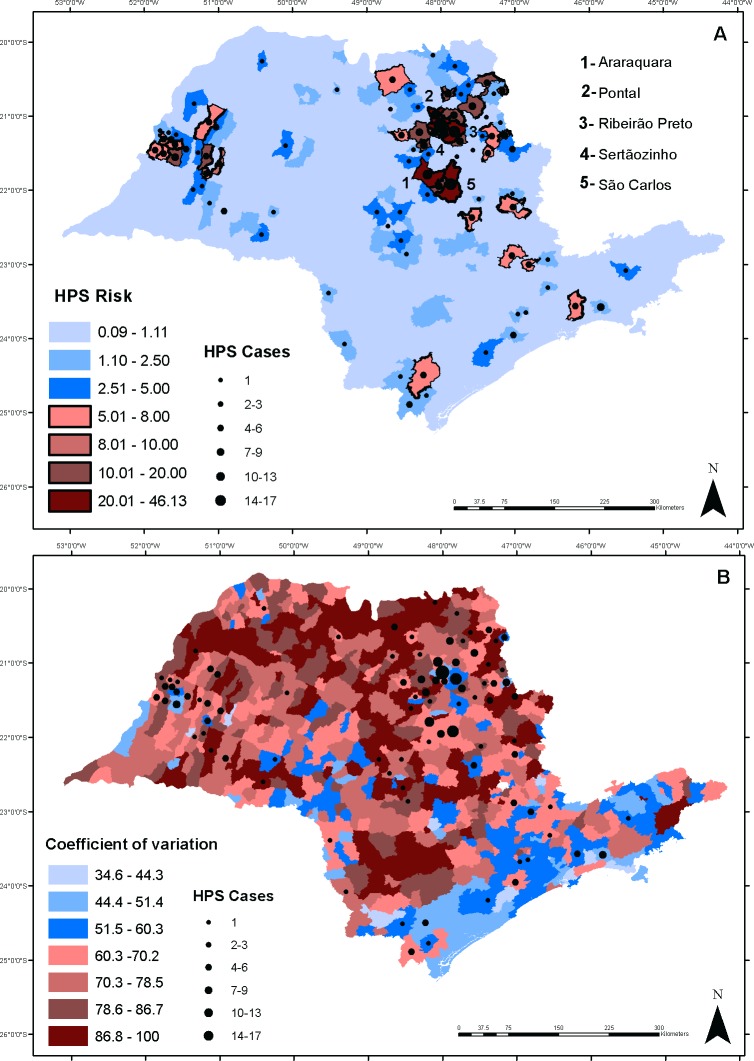
Map of Hantavirus infection probability (%) (A) mean (B) and coefficient of variation (B) among years across the state of São Paulo. Black dots depict number of reported cases between 1993 and 2012. Municipalities with no symbol means no reported cases of HPS. Black outlines indicate municipalities with medium to high risk (> 5%) of Hantavirus infection and where preventive effort should be allocated.